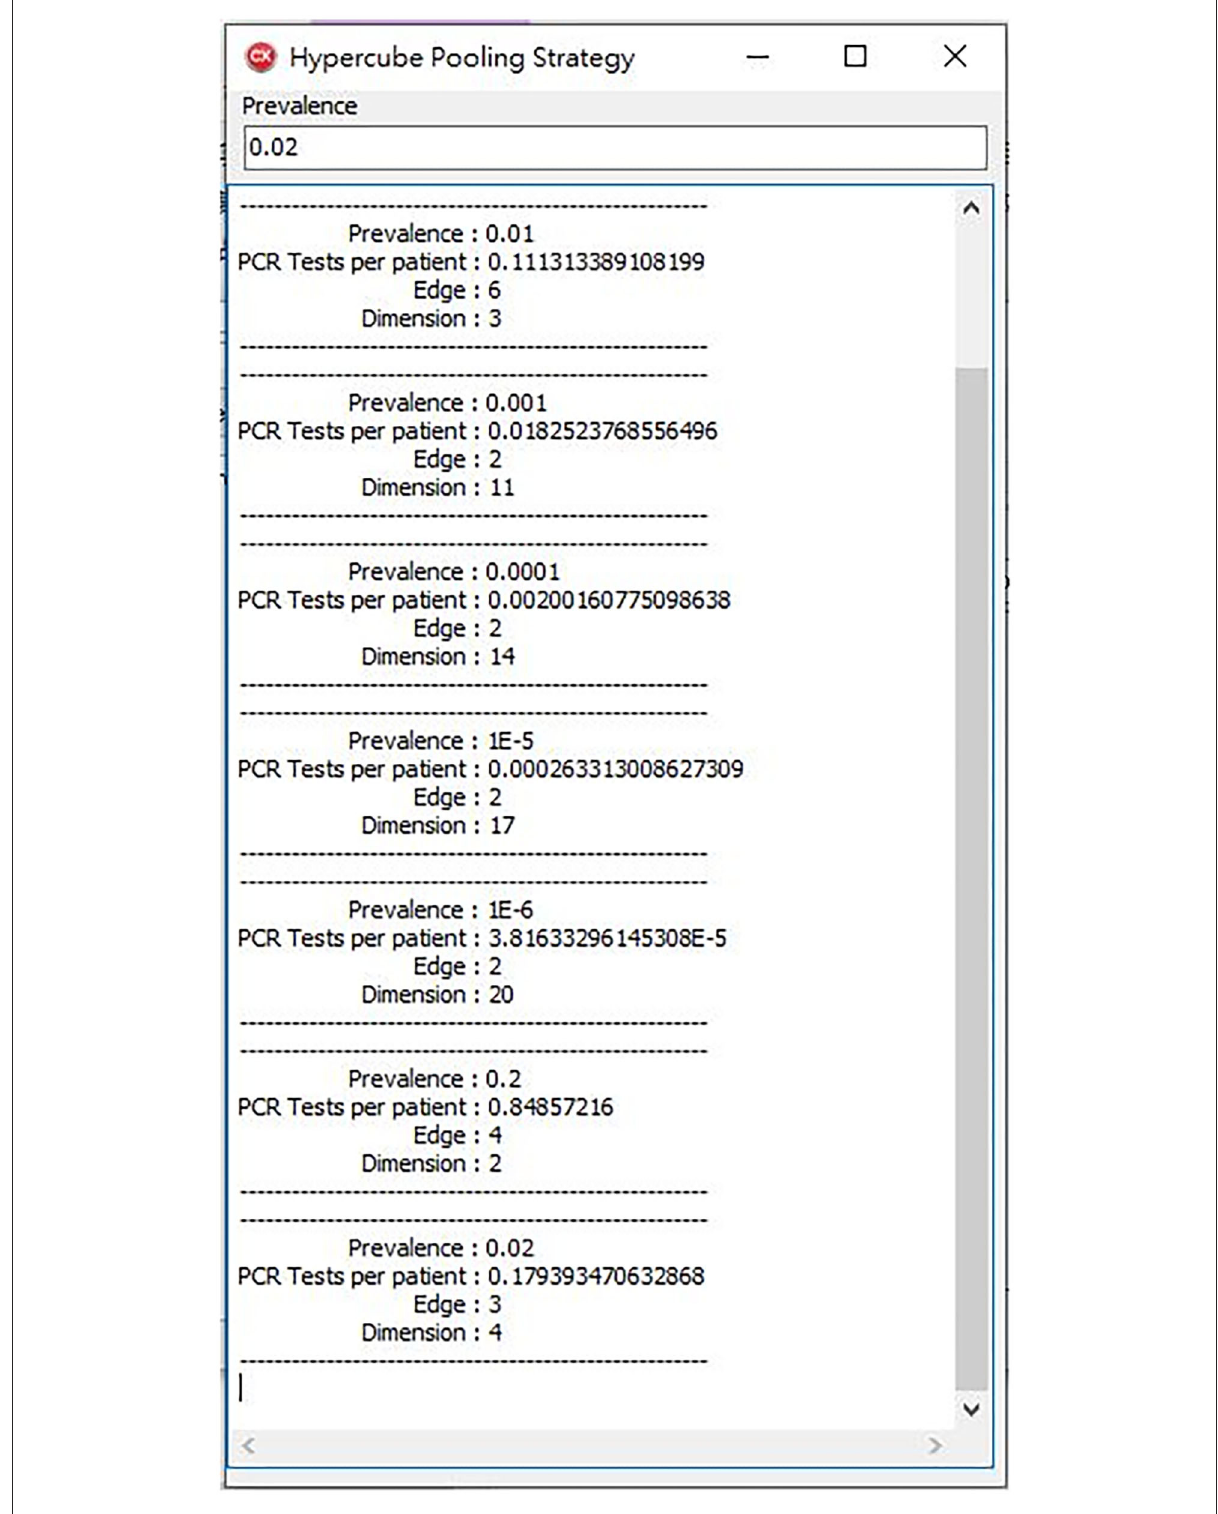
FIGURE3 Our program offers a high-performance hypercube pooling strategy. The dimension, edge, and expected number of PCR tests per patient are the output variables.